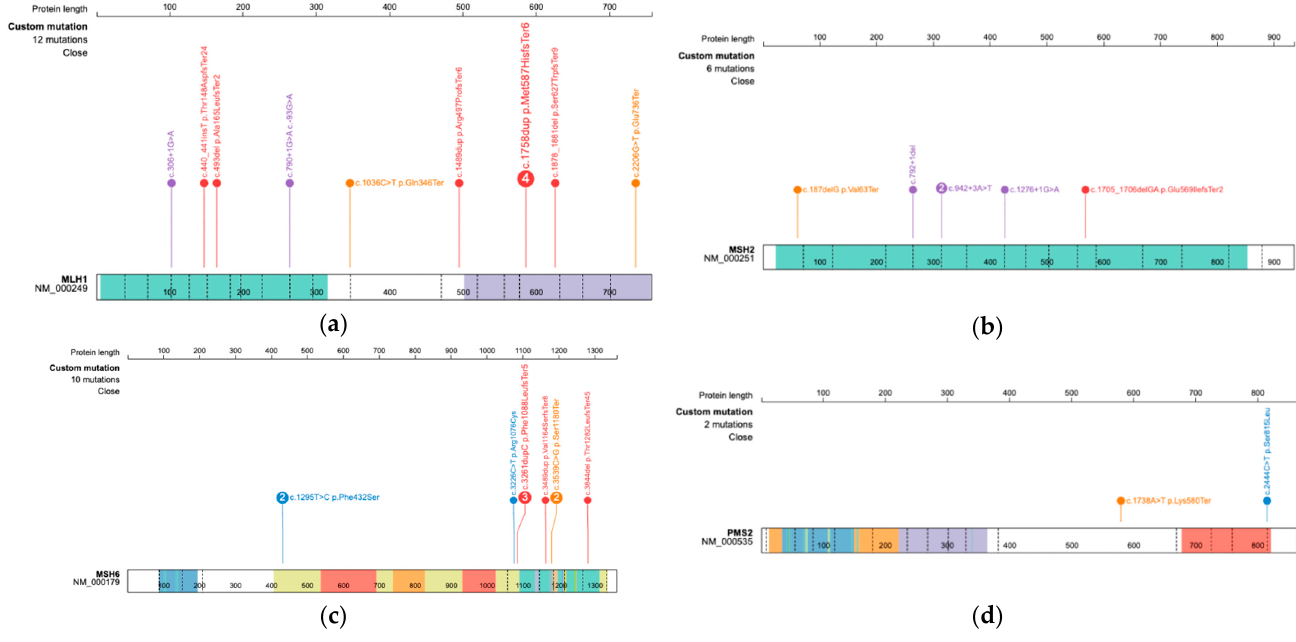
Figure 2. The location and type of ( a ) MLH1 , ( b ) MSH2 , ( c ) MSH6 , and ( d ) PMS2 mutations within each chromosome are described with a mutation